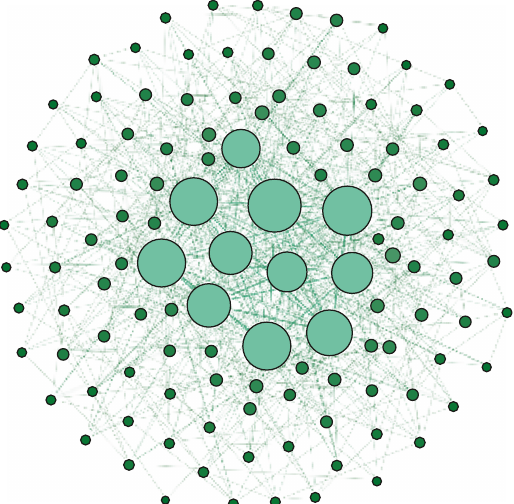
Figure 3: Bankingnetworkwith120banks.Thenodesizeisweighted by its degree. Large banks are colored in light green, whereas small banks are colored in dark green. The network is constructed using the default values of the model parameters (Section 3.2) and has a core-periphery structure: large banks with many links are densely interconnected — forming the core, and small banks with few links are loosely interconnected — forming the